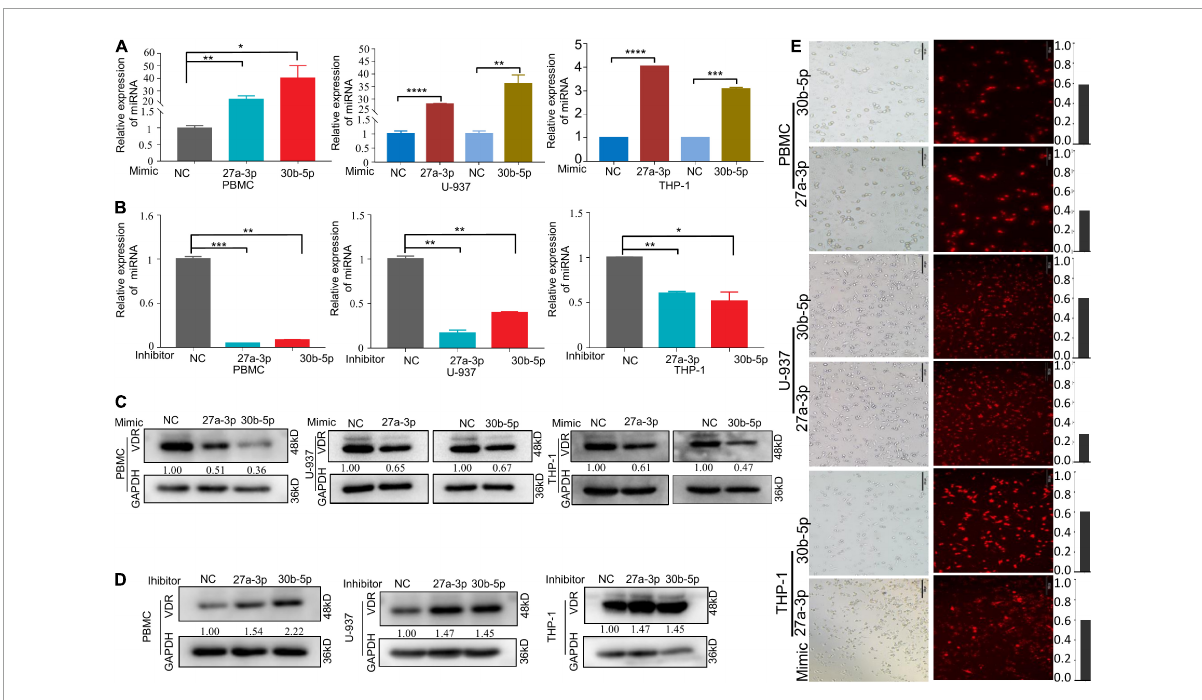
FIGURE4 MiR-27a-3p and miR-30b-5p downregulate the protein levels of VDR in activated M1 macrophages. (A) The relative expression of miRNAs after transfection with miR-27a-3p and miR-30b-5p mimics in monocytes. (B) The relative expression of miRNAs when transfected with inhibitors. (C) VDR protein levels were obviously decreased when miR-27a-3p and miR-30b-5p mimics were transfected for 48 h, compared with the negative control group. (D) When transfected with miR-27a-3p and miR-30b-5p inhibitors, VDR protein levels were clearly upregulated compared with that in the negative control group. (E) The efficiency of the transfection was observed by fluorescence microscopy when miR-27a-3p and miR-30b-5p with Sulfo-Cyanine5 (Cy-5) dye were transfected into monocytes for 48 h. * P < 0.05, ** P < 0.01, *** P < 0.001, **** P < 0.0001, ns = not